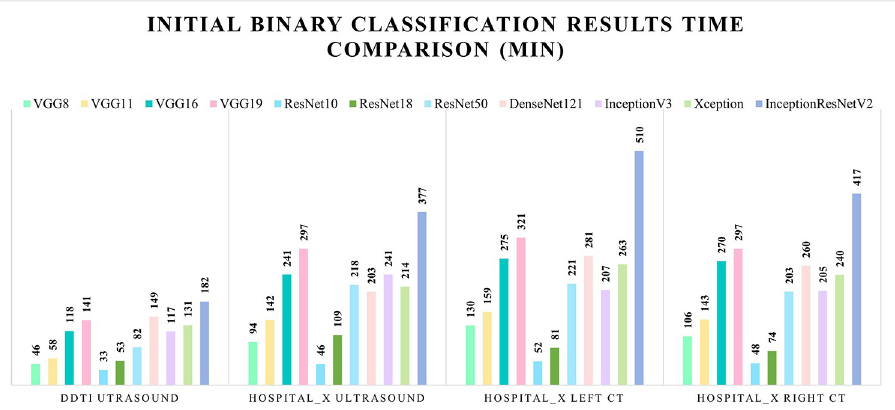
Fig 8. Initial binary classification task running time comparison for the 11 models.